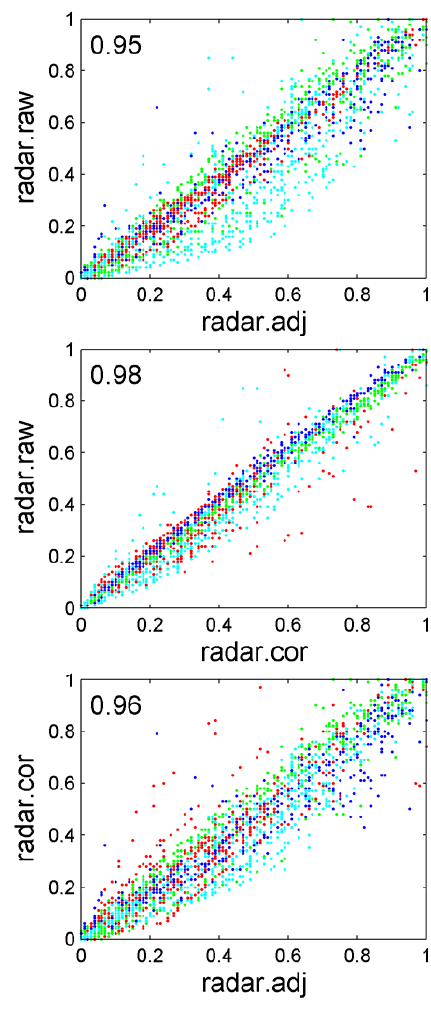
Fig. 3. Scatterplots of the FSS values for 3h rainfalls and vari- Fig.3. Scatterplots of the FSS values for 3 h rainfalls and various radar-based data types. Each ous radar-based data types. Each graph includes FSS values from graph includes FSS values from all events, integration times, scales, and threshold values (1, all events, integration times, scales, and threshold values (1, 2, 5, 10mm). The set of FSS values correspond to the mean FSS from 2, 5, 10 mm). The set of FSS values correspond to the mean FSS from Fig. 2 (black curves). Fig. 2 (black curves). Single color refer to the events as follow: red Single color refer to the events as follow: red - 13.7.2002, green – 15.7.2002, blue – – 13 July 2002, green – 15 July 2002, blue – 10 June 2004, and cyan – 23 May 2005. Correlations are given in each 10.6.2004, and cyan – 23.5.2005. Correlations are given in each panel.